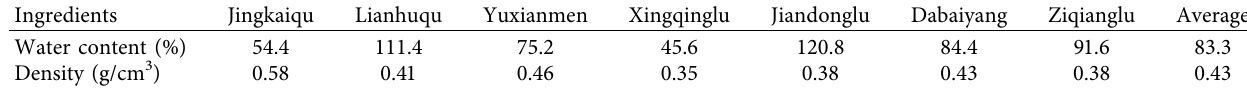
Table 3: Water content and density of MSW in Xi’an.